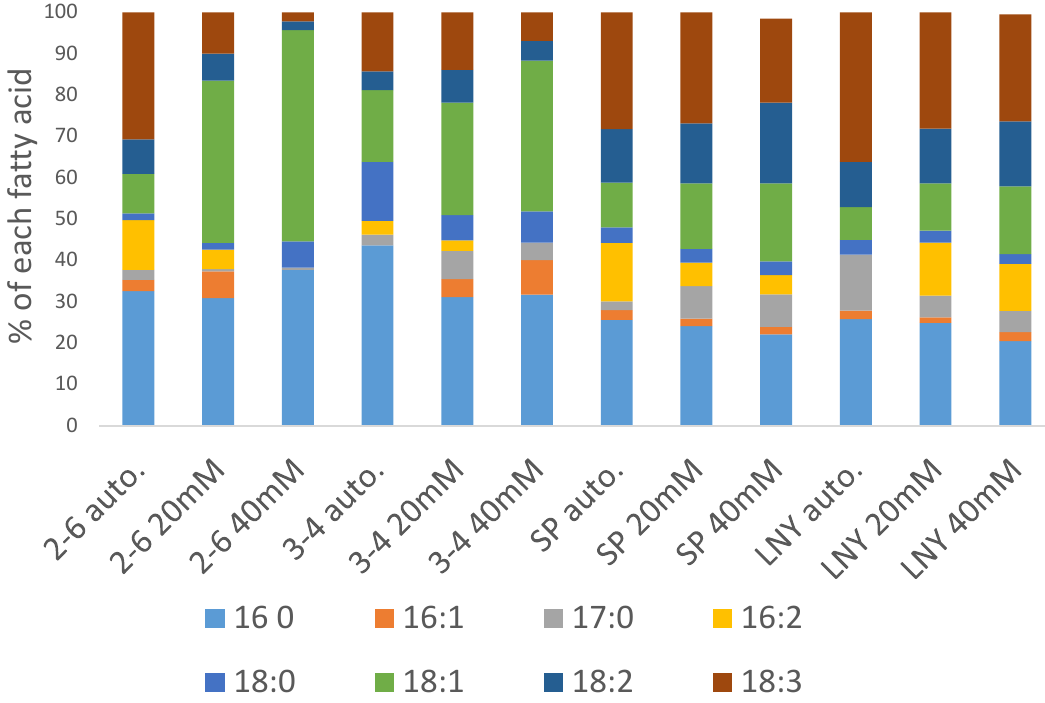
Figure 5. Fatty acid composition of algal strains grown under autotrophic conditions (auto) and heterotrophic conditions with 20 or 40 mM glycerol (designated 20 mM and 40 mM, respectively). Means, Standard errors are 0.1–4.2% of means, n = 3.